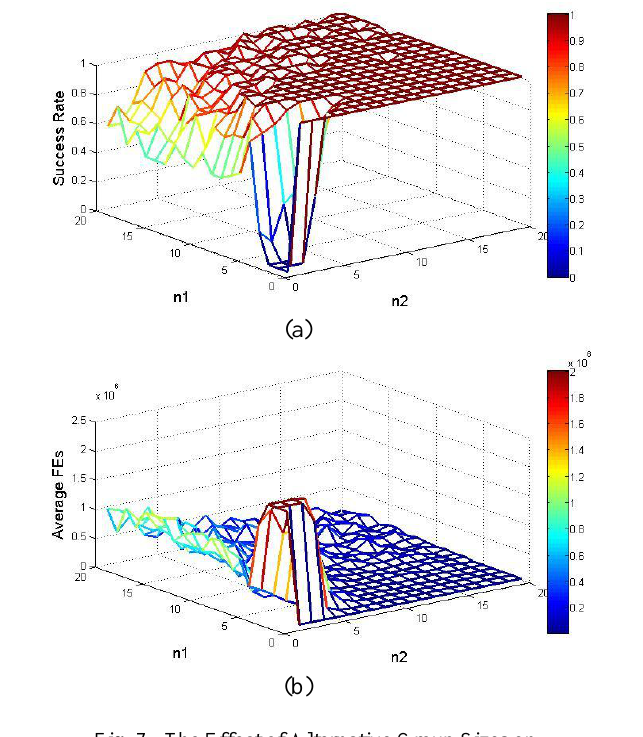
Fig. 7 The Effect of Alternative Group Sizes on Optimization Schaffer 1 Problem (SF1) of 5- dimension (a) Result of Success Rate, (b) Result of Average Function